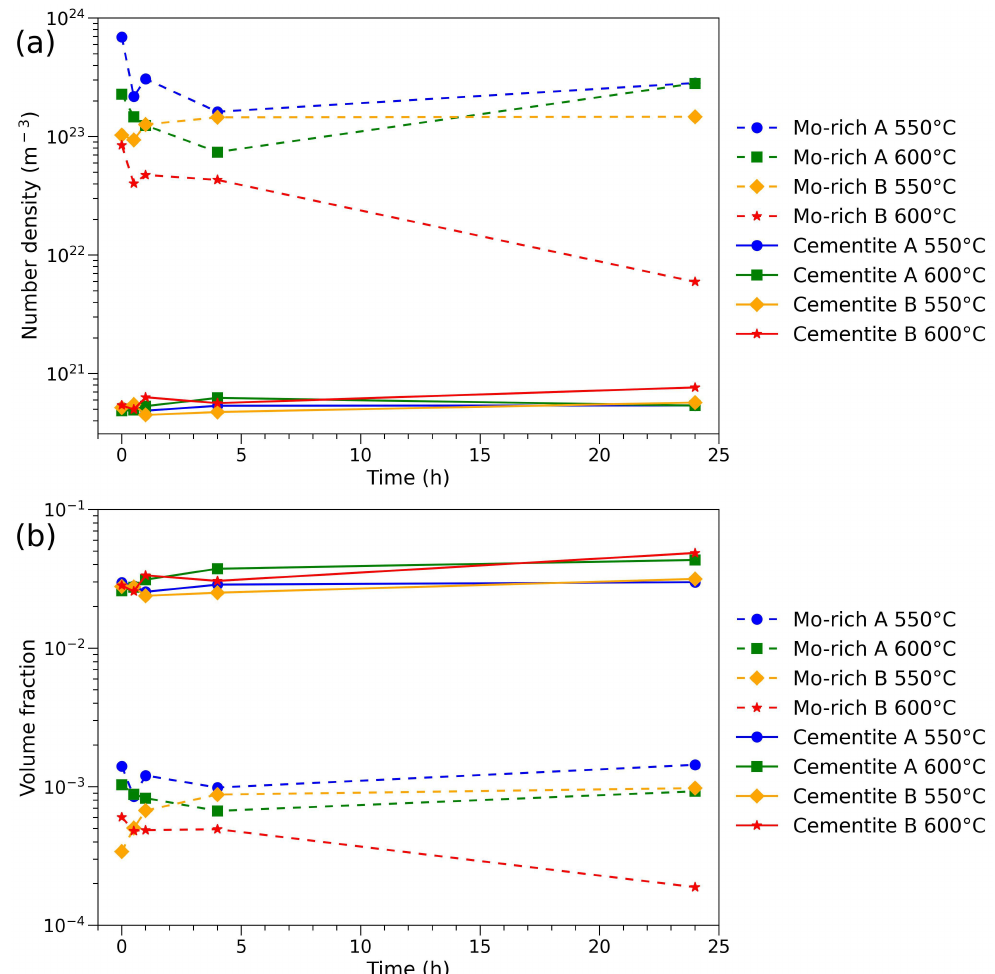
Figure 10. Results from the SANS modeling for both materials and tempering temperatures. ( a ) Num- Figure 9 ber density and ( b ) volume When analysing compliance with the speed limit for both genders, in the no-campaign scenario, male participants did not respect the speed limit in 30.48% of situations, while female participants did not respect the speed limit in 20.83% of situations. The percentage of non-compliance with speed decreases for both genders in the scenario when the campaign was shown on billboards (men—23.02%, women—18.4%), while respondents of both genders exceeded the speed limit in the scenario when their campaign message was displayed on a smartwatch (men—14.13%, women—12.5%). These results are consistent with a study conducted by Etika et al. (2021), showing that male drivers are more willing to exceed the speed limit than females. When analysing PST, AMS and AS, a similar conclusion can be drawn, that male participants drive in longer time intervals above the speed limit, have a higher top speed over the speed limit and have higher average overspeed values, unlike female participants. The presented results are in line with many